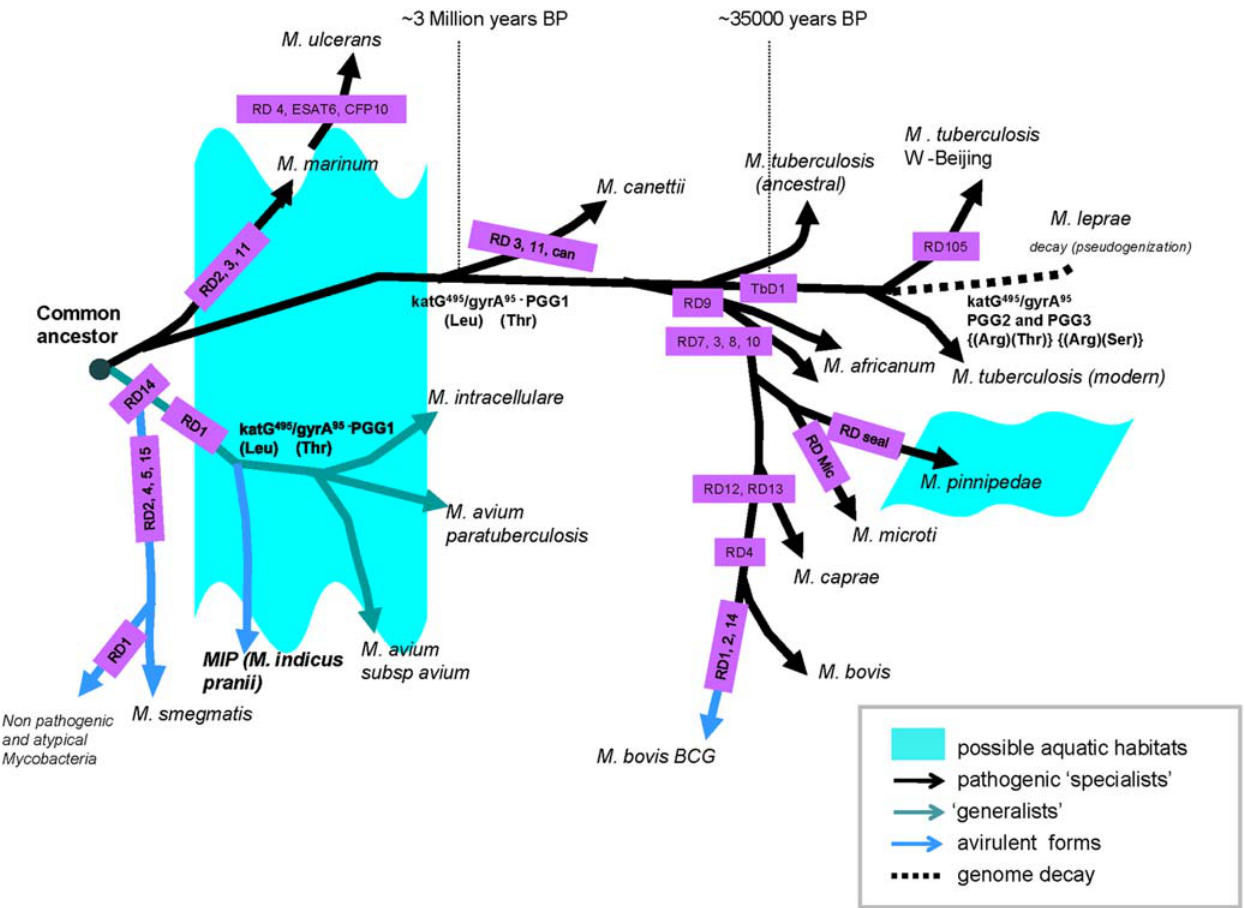
Figure 4. Landscape of genome evolution across the ‘generalist’ and ‘specialist’ mycobacterial lineages. Various RDs refer to genomic deletion points as discussed elsewhere [24]. Divergence of M. tuberculosis W-Beijing was deduced based on the RD105 [41]. The inferred time points of some important lineage divergences mentioned as years-before-present (years BP) on the basis of the conventions established earlier [15,24,42]. For further details please refer to manuscript